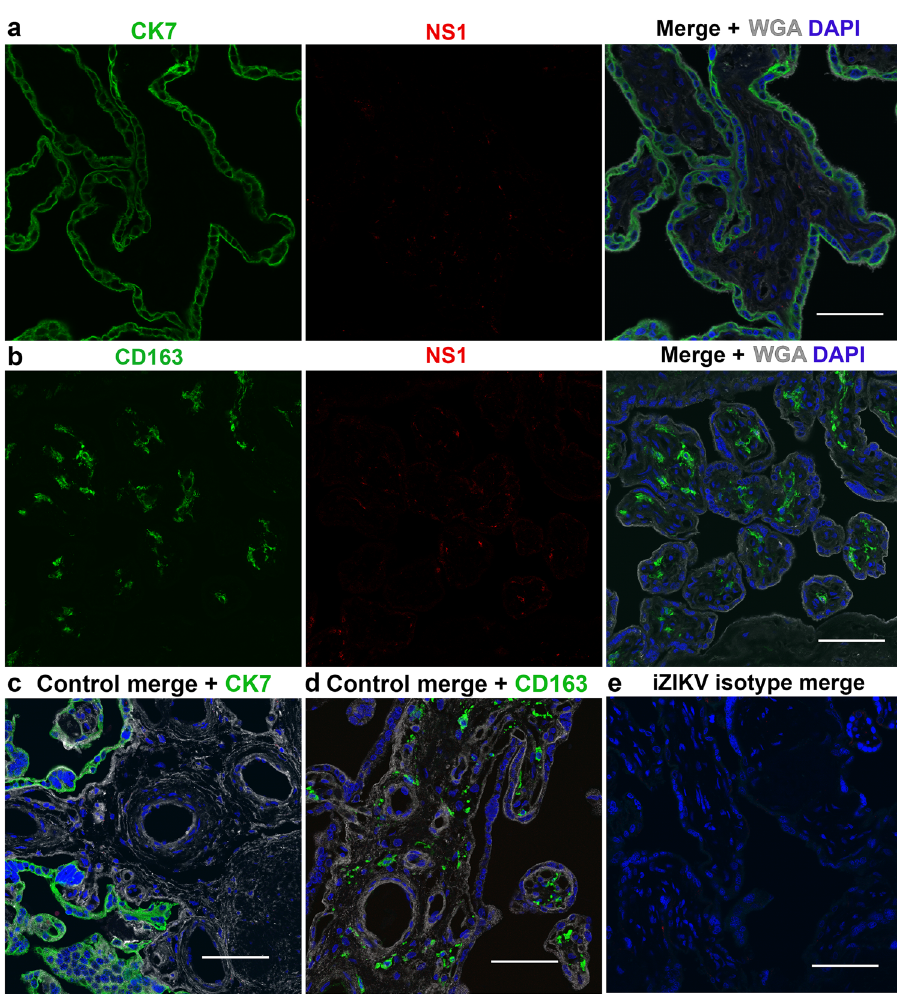
Fig. 4 Absence of NS1 in iZIKV perfused cotyledons. a – b Confocal images acquired from cotyledons exposed to iZIKV. Parallel to Fig. 4 sections were stained with Cytokeratin 7 (CK7) or CD163 depicted in green, along with NS1 in red, the lectin WGA in gray and DAPI as blue. c – d Merged images of NS1, WGA, DAPI, and CK7 or CD163 staining ’ s in control cotyledons perfused in parallel to iZIKV. e Representative image of serial sections from iZIKV exposed samples stained with IgG isotype antibodies in place of anti-CK7, CD163 and NS1. Scale bars = 50 µ